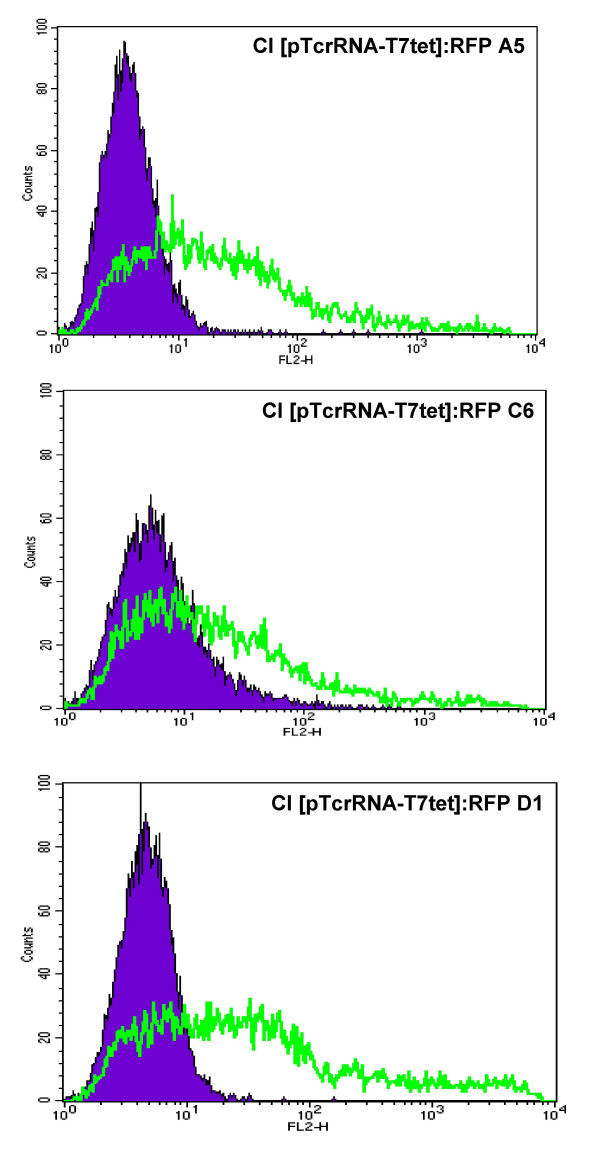
FACscan analysis of expression of RFP in 3 independent clones in the CL [pTcrRNA-T7tetR] background. Tetracycline (0.5 μg ml-1) was added and samples were removed and fixed after 6 days. The level of fluorescence in the population was measured by counting 5 × 103 cells per timepoint. The filled area indicates the uninduced cells, while the green line represents the induced population. The Y axis indicates the number of cells counted, whilst the X axis shows the level of fluorescence in AFU.